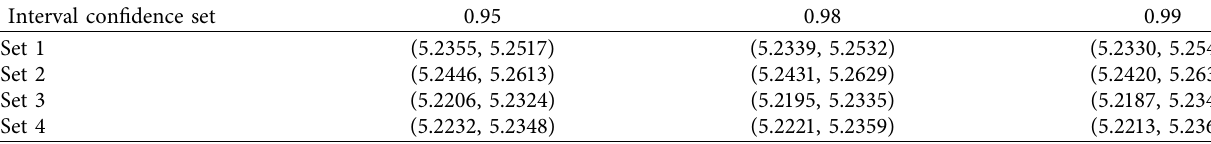
Table 3: The population mean μ z takes the two-sided confidence interval of each confidence level.